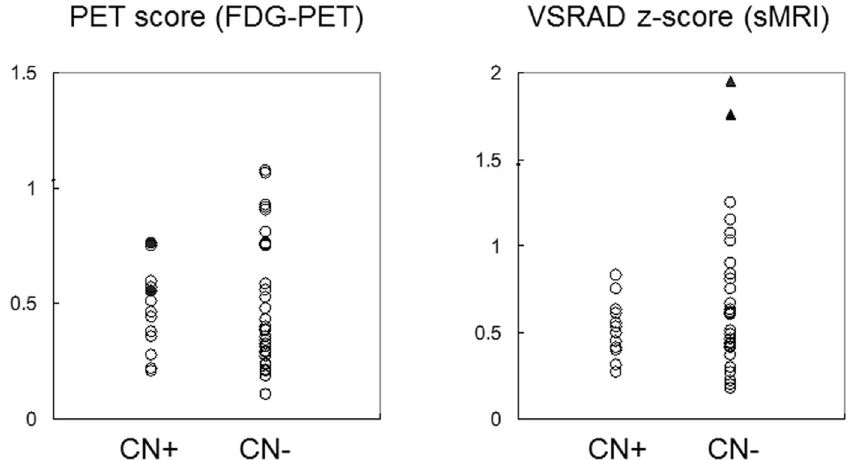
Figure 5. Scatter plots of the quantitative image analyses. Left: FDG-PET scores in CN + subjects and CN − subjects. The closed circles indicate two cases who were visually rated as having probable Alzheimer’s disease- like metabolic changes. Right: VSRAD z-scores in the two groups. The closed triangles indicate the two outliers defined by the Tukey method. CN + : cognitively normal PiB-positive, CN − : cognitively normal PiB-negative, VSRAD: Voxel-based Specific Regional Analysis System for Alzheimer’s